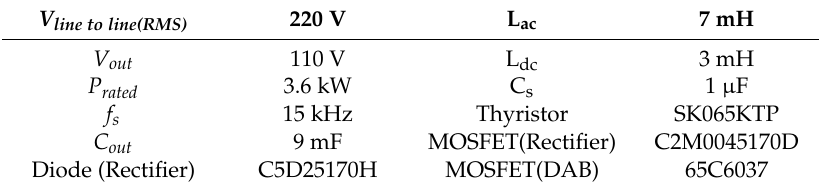
Figure 12. Photograph of experimental setup. Table 1. System Parameters.